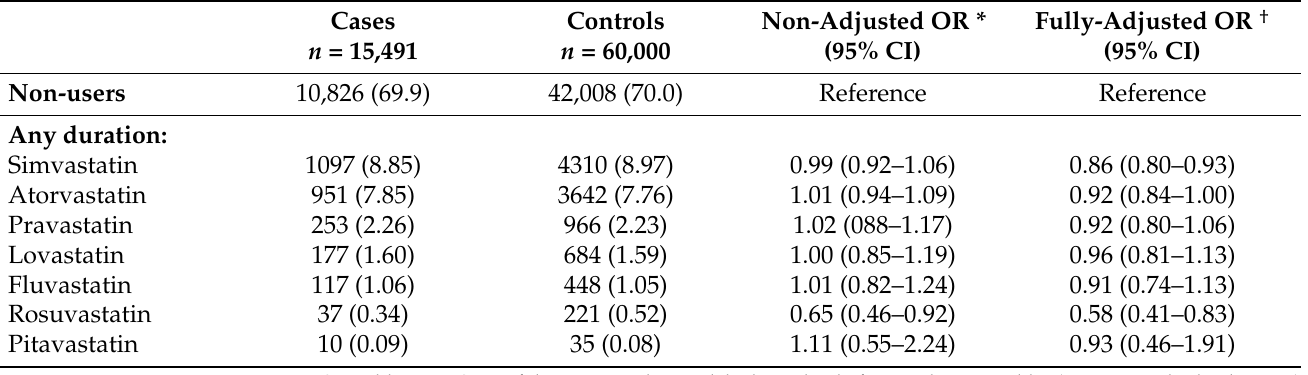
Table 3. Current use of individual statins and risk of colorectal cancer.